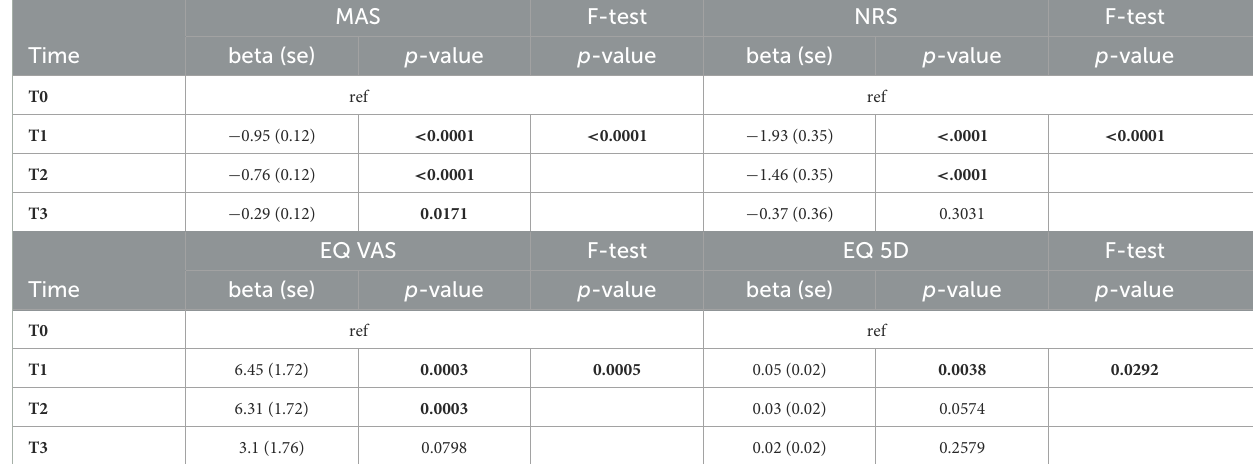
TABLE 4 Beta regression model of time effect on the considered variables (MAS, NRS, EQ VAS, and EQ 5D) up to T3. MAS F-test F-test